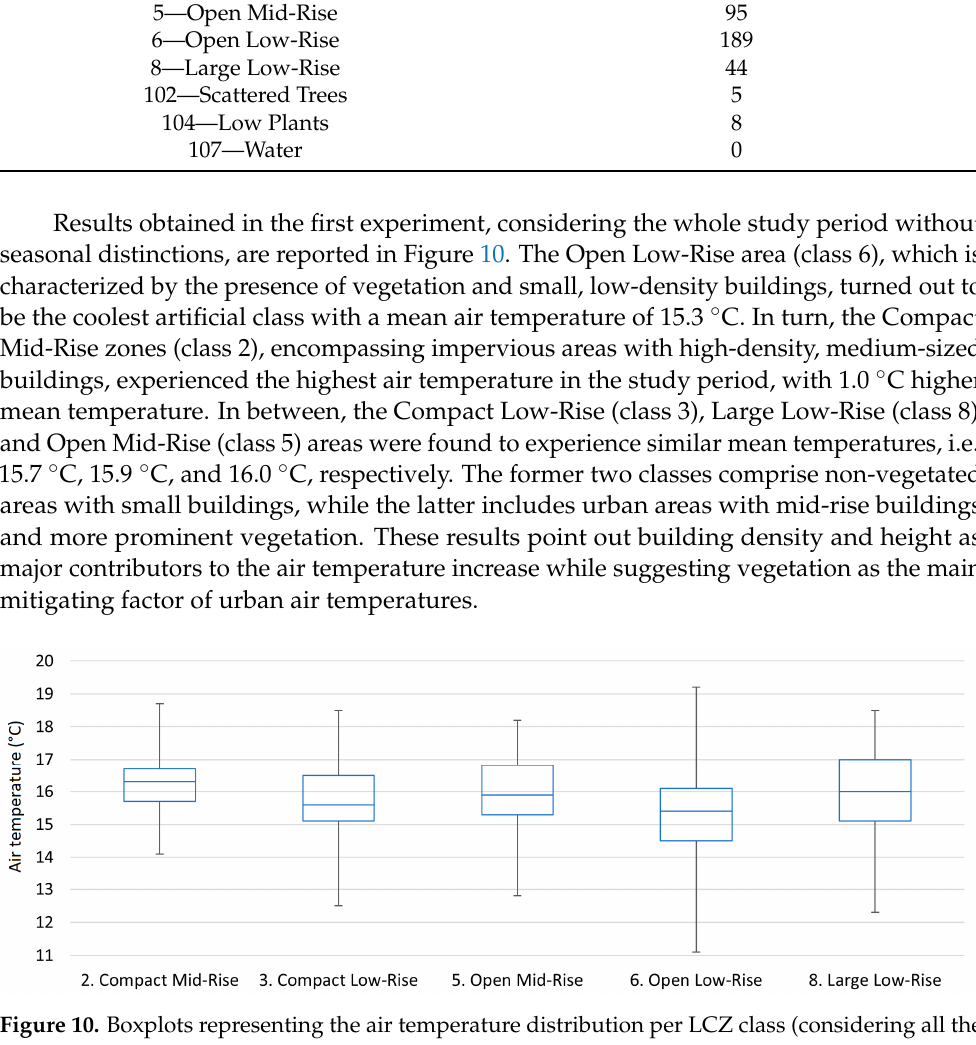
Table 7. Number of air temperature stations per LCZ class.